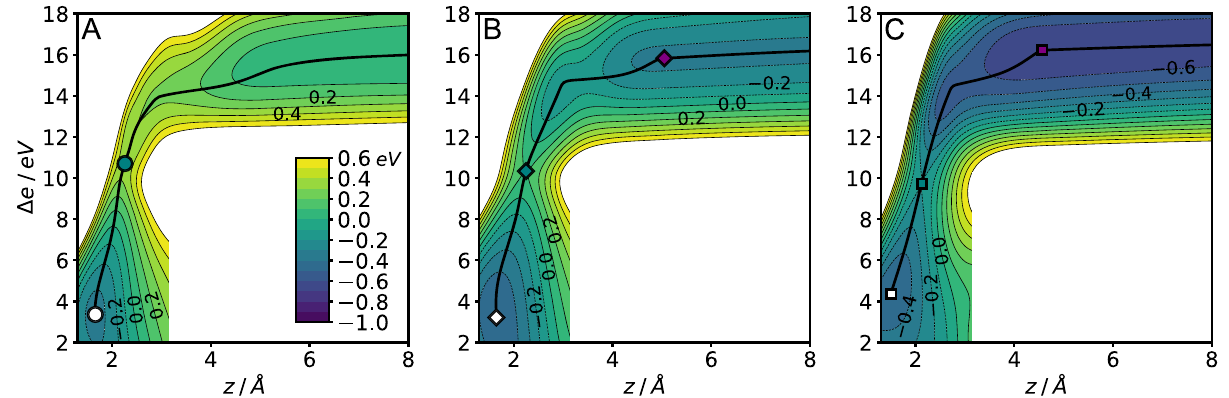
Fig.5|Simulatedadiabaticfreeenergysurfacesofthe H + / H redoxpairnearaPt (111)electrodeasfunctionsofthecollectivesolventcoordinate, Δ e ,andtheH ’ s z -coordinate along the normal to the surface, at varying cell electrostatic potentials. A V (cid:2) V pzc = (cid:2) 0V B V (cid:2) V pzc = (cid:2) 1V C V (cid:2) V pzc = (cid:2) 2V. The Fermi level is set such that ϵ a (cid:2) ϵ f = (cid:2) 10 : 19 eV . Minimum free energy paths (MFEP) are